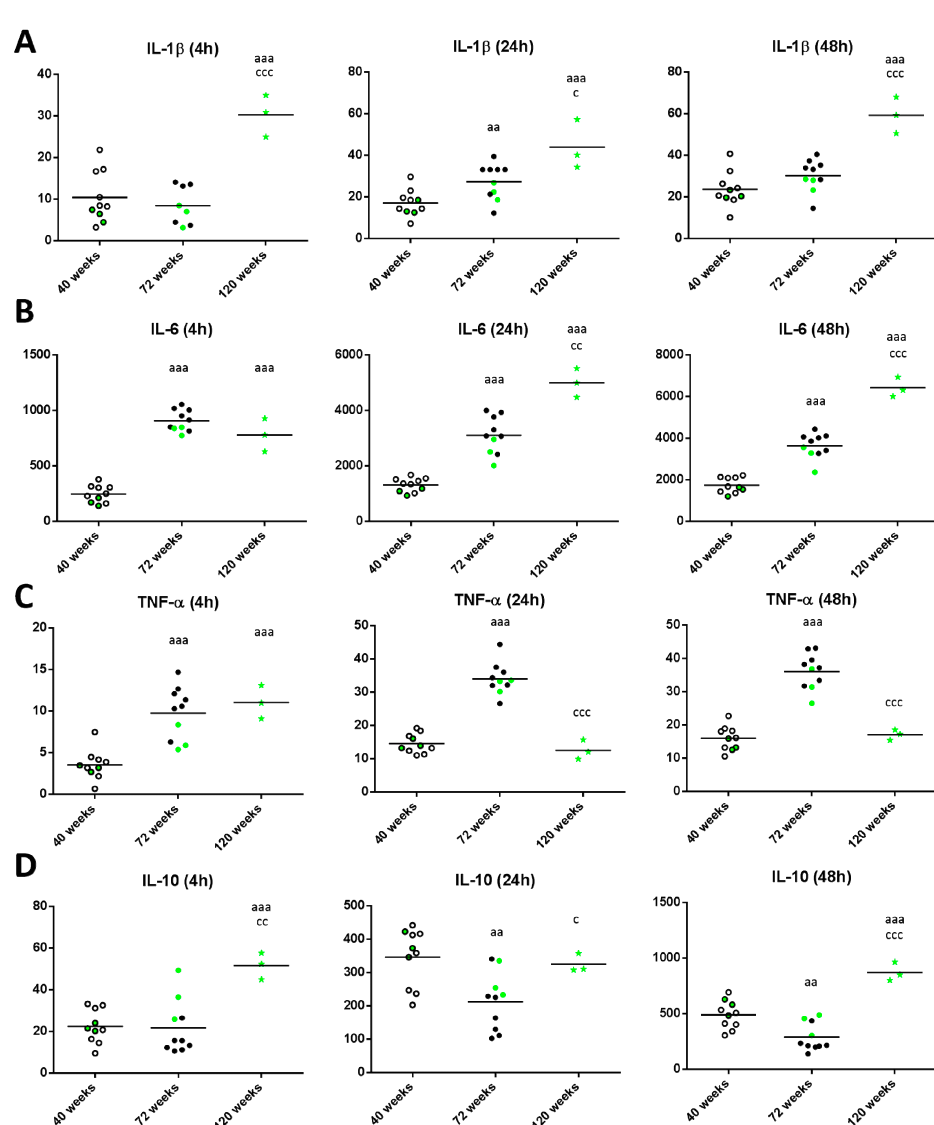
Figure 5. Levels (pg/mL) of IL-1 β ( A ); IL-6 ( B ); IL-17 ( C ); TNF- α ( D ) and IL-10 ( E ) released by peritoneal leukocytes from adult (40 weeks), old (72 weeks) and long-lived (120 weeks) mice after 4, 24 and 48 h of culture. The green points represent the values in mice that reached 120 weeks. aa: p < 0.01; aaa: p < 0.001 with respect to the value in adult mice. c: p < 0.05; cc: p < 0.01; ccc: p < 0.001 with respect to the value in old mice.